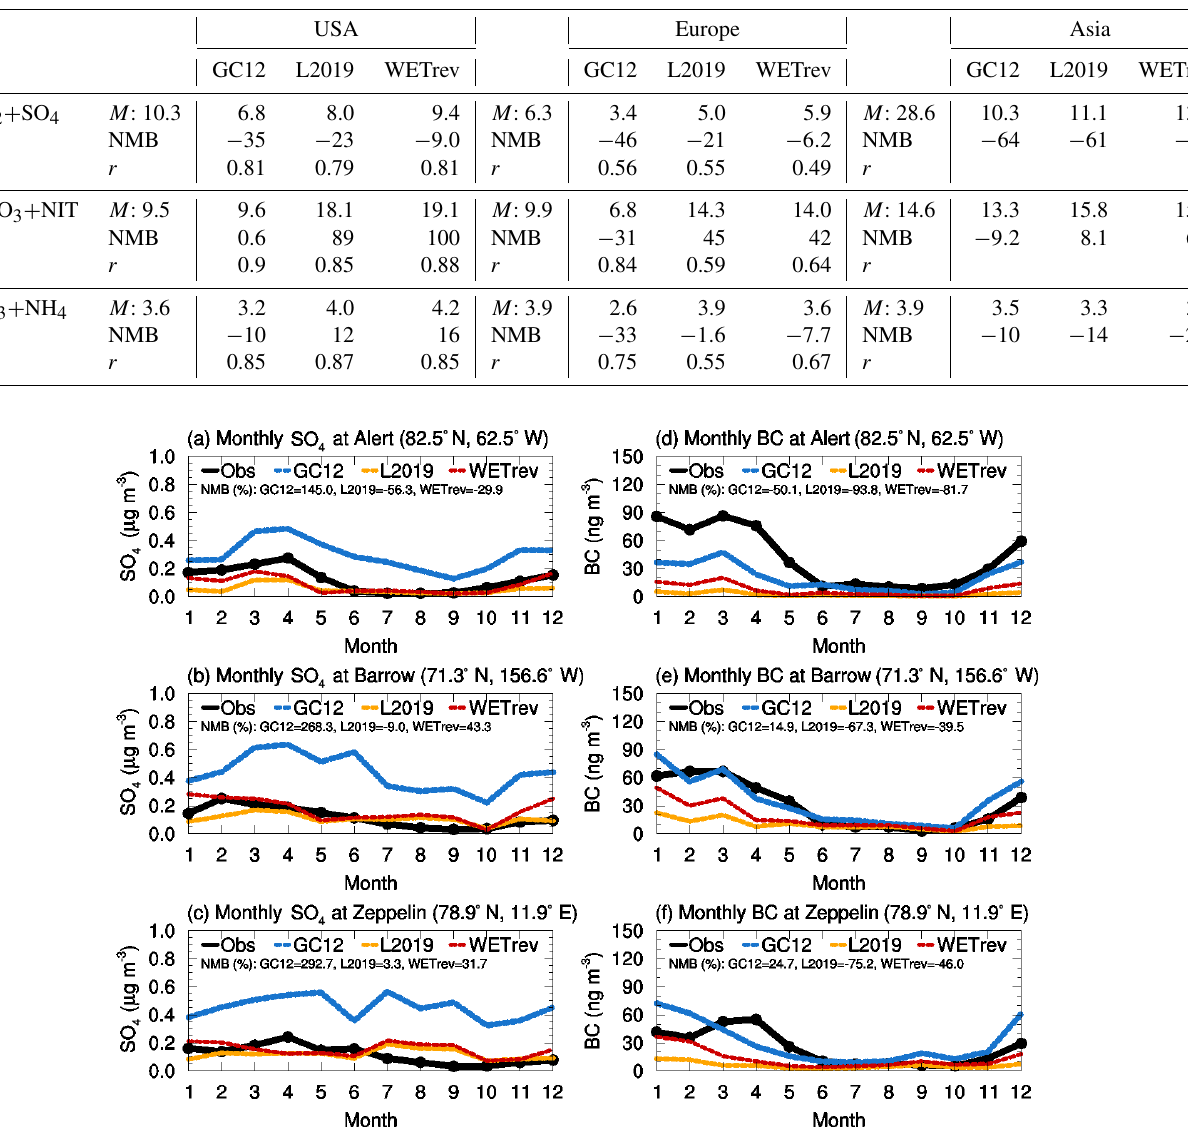
Figure 7. Variations of multiyear monthly means showing the comparisons of (a–c) sulfate and (d–f) black carbon surface mass concen- trations which were observed at (a, d) Alert (2008-2012), (b, e) Barrow (2008–2013), and (c, f) Zeppelin (2008–2013) sites (black) and simulated (2011) by GC12 (blue), L2019 (yellow), and WETrev (red)